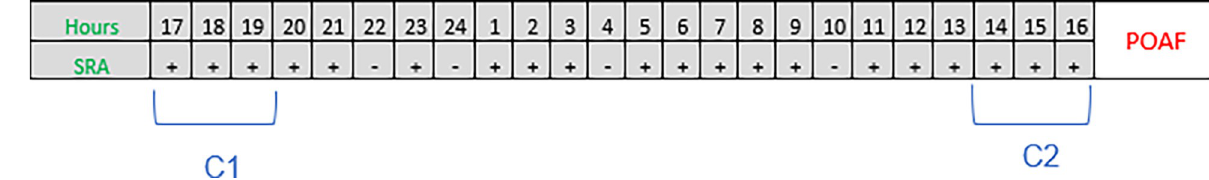
PLOS ONE | https://doi.org/10.1371/journal.pone.0282565 March 15,